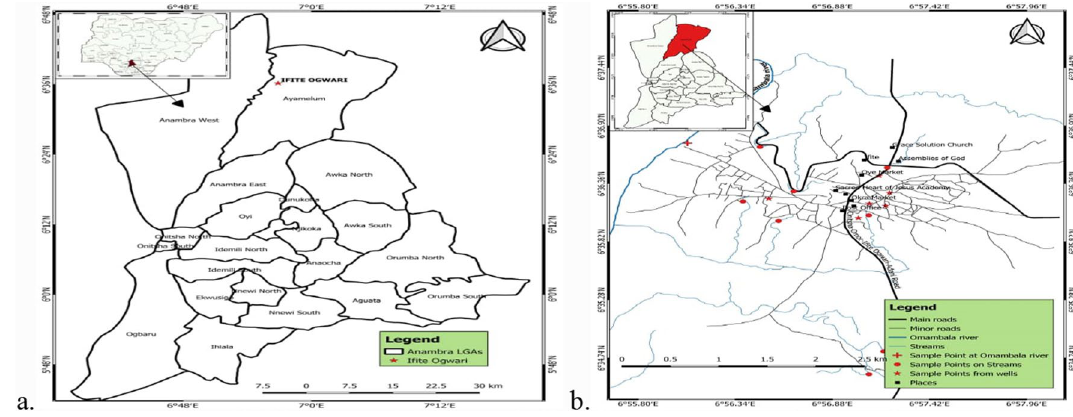
Fig. 1 a Map of Anambra State, Nigeria showing Ifite Ogwari, b map of Ifite Ogwari showing sample collection